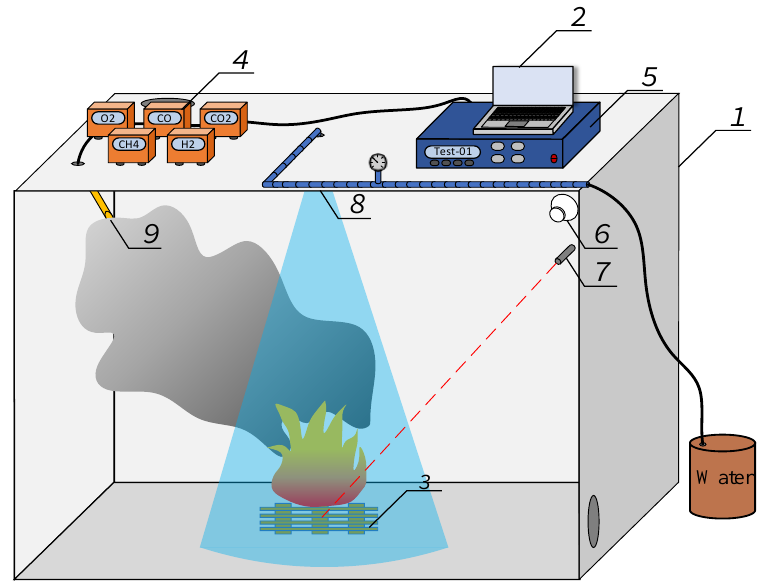
Figure 1. Experimental setup: 1 — box with dimensions 1.5 × 1 × 1.25 m; 2 — PC; 3 — laboratory-scale